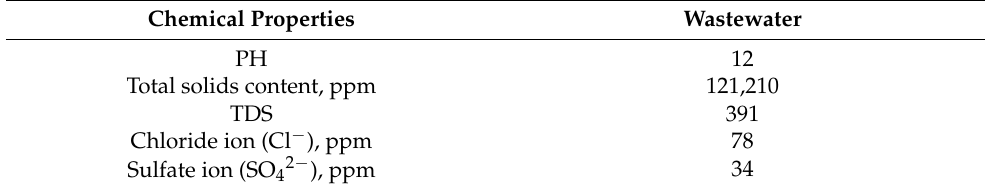
Table 1. Chemical properties of